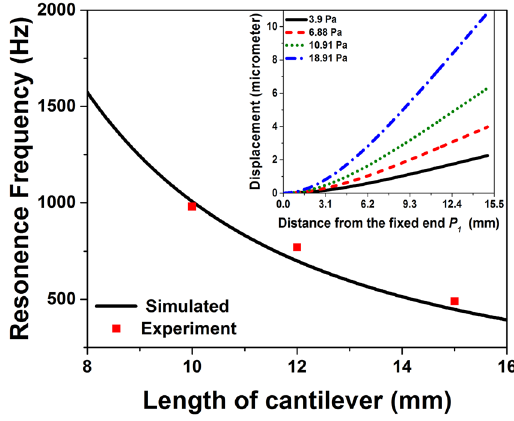
Figure 3. Variation of resonance frequency with cantilever length; Inset shows the displacement of micro-tip cantilever under different applied acoustic pressure.